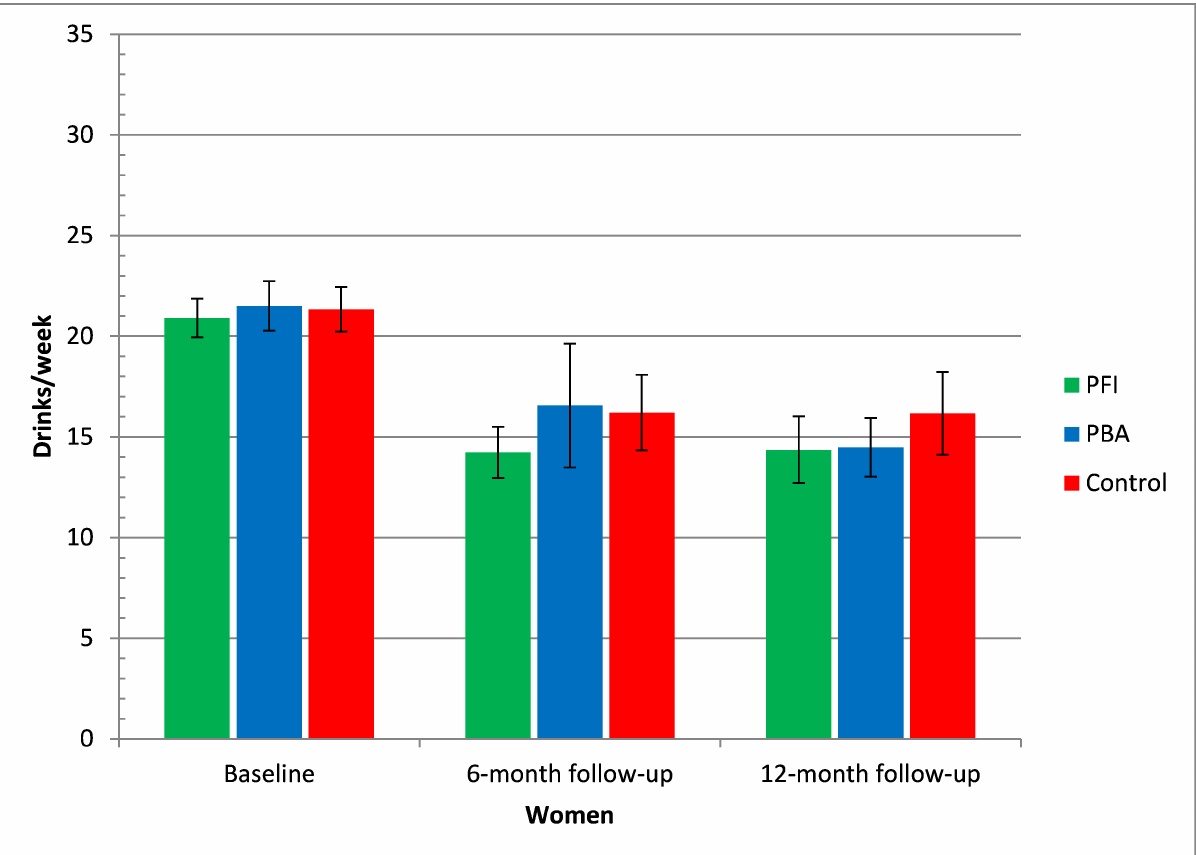
Figure 7. Alcohol consumption at baseline and at 6- and 12-month follow-ups for women based on completers-only analysis. n = 390 after 6 months and 466 after 12 months. Error bars indicate 95% confidence interval. Drinks/week = mean number of standard drinks in a typical week, PBA = Internet-based personalized brief advice intervention, PFI = Internet-based brief personalized feedback